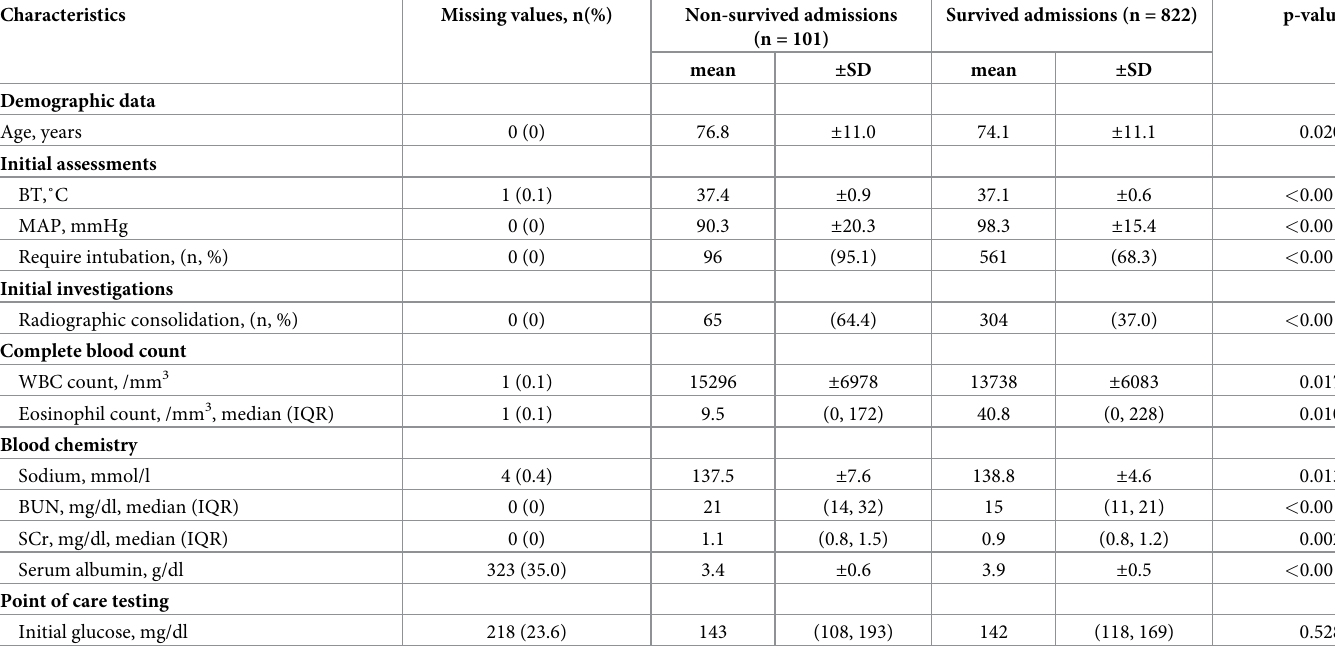
Table 2. Pre-specified candidate clinical predictors of non-survived and survived admissions of AECOPD patients (n = 923 admissions).